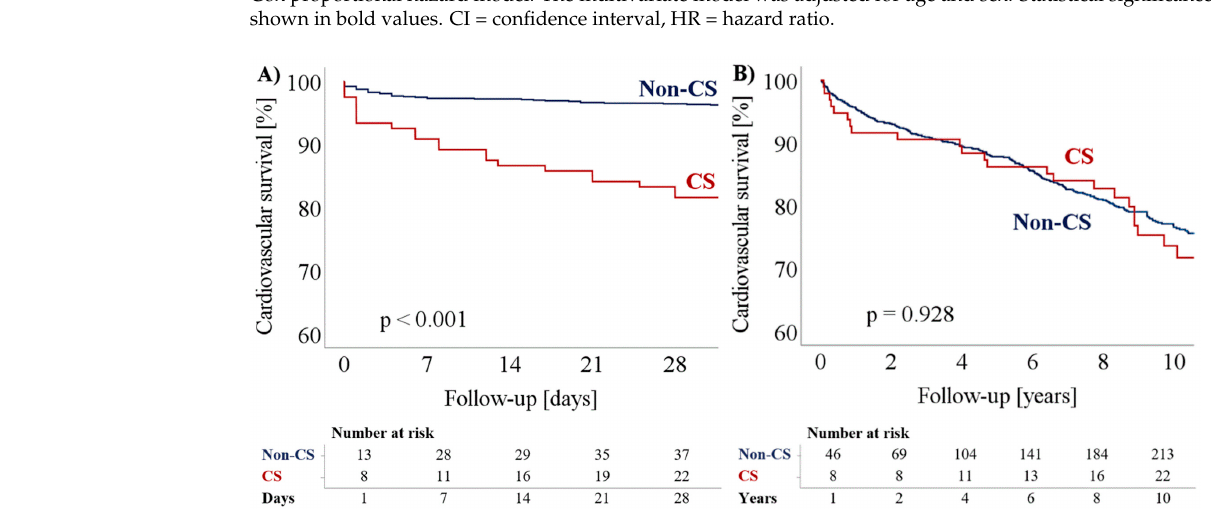
Figure 1. Accumulated cardiovascular survival comparing hemodynamically stable patients to patients with cardiogenic shock, ( A ) during the acute event, p < 0.001 and ( B ) after survival of the acute event, p = 0.928. CS = cardiogenic shock.